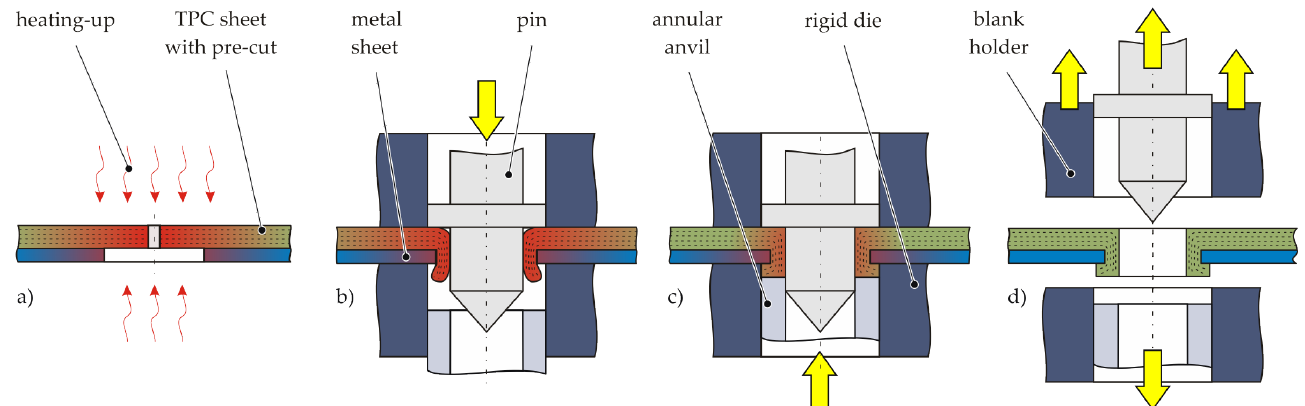
Figure 3. Schematic illustration of the Thermoclinching process based on [16]: ( a ) positioning of the pre-cut joining partners and heating-up of the joining zone, ( b ) permeating of the fibre reinforced structure with the tapered pin, ( c ) forming of the undercut, ( d ) releasing finished